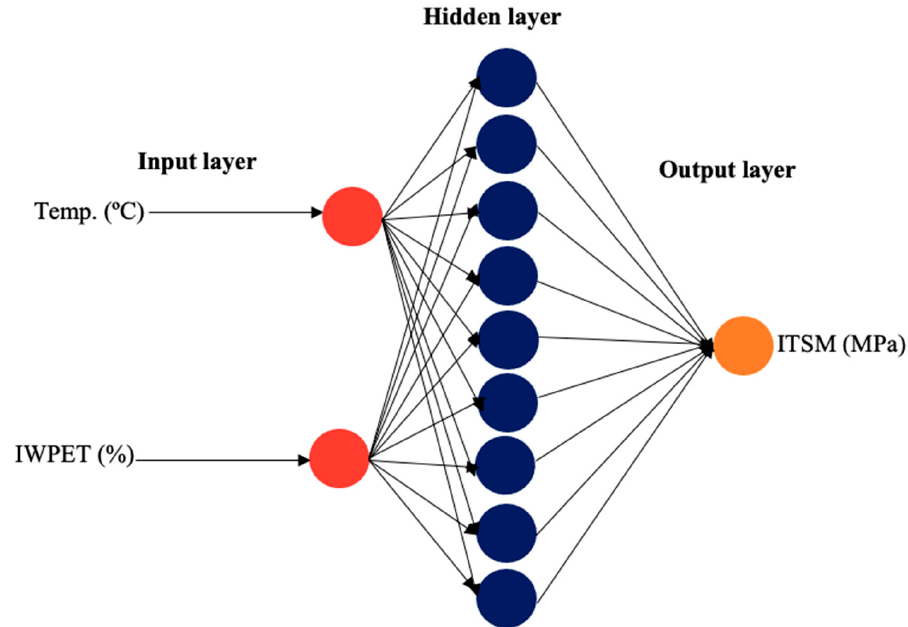
Figure 15. ANN topology for the stiffness modulus response of the modified asphalt mix.